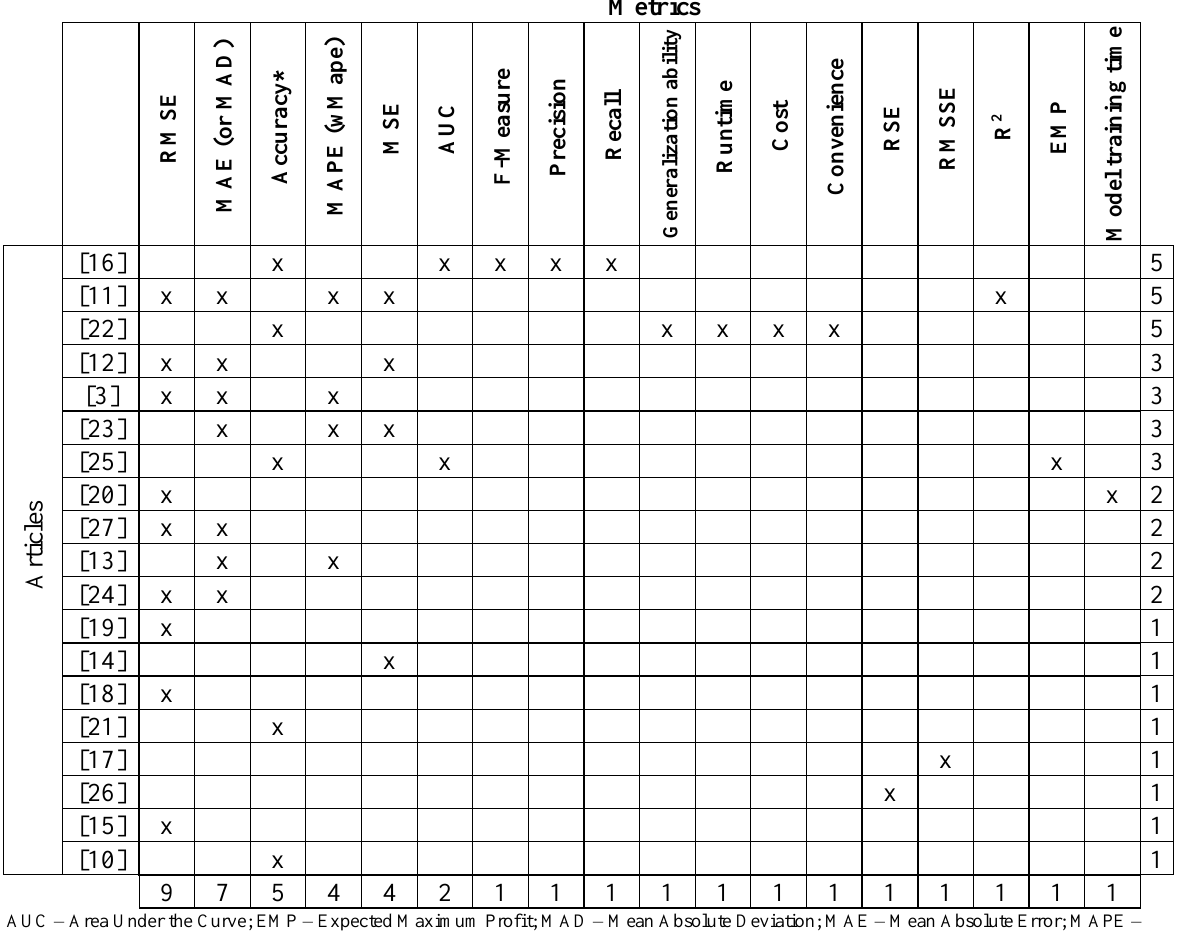
Table 3. List of metrics used in reviewed studies Metrics